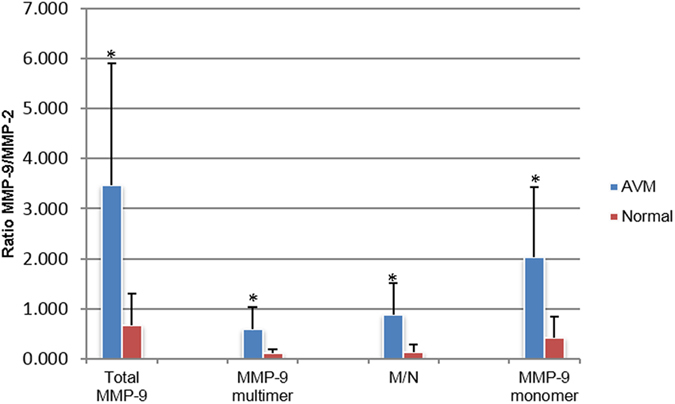
Comparison of enzymatic levels of MMP-9 in AVMs and normal tissues.Comparison of enzyme levels of MMP-9 and its complex normalized to enzyme level of MMP-2 between AVMs versus normal tissues. *significant difference. A, AVM; N, normal tissue; M/N, MMP-9/NGAL complex.